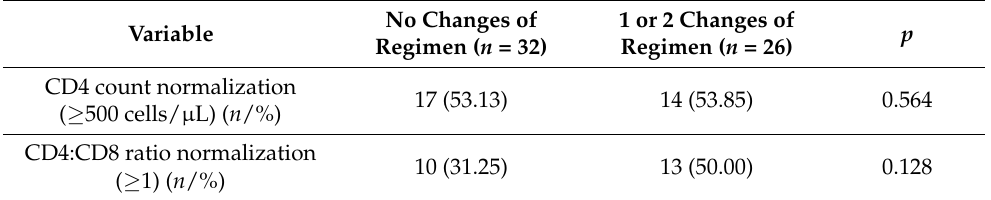
Table 9. CD4 cell count and CD4:CD8 normalization depending on changes in the ART regimen.